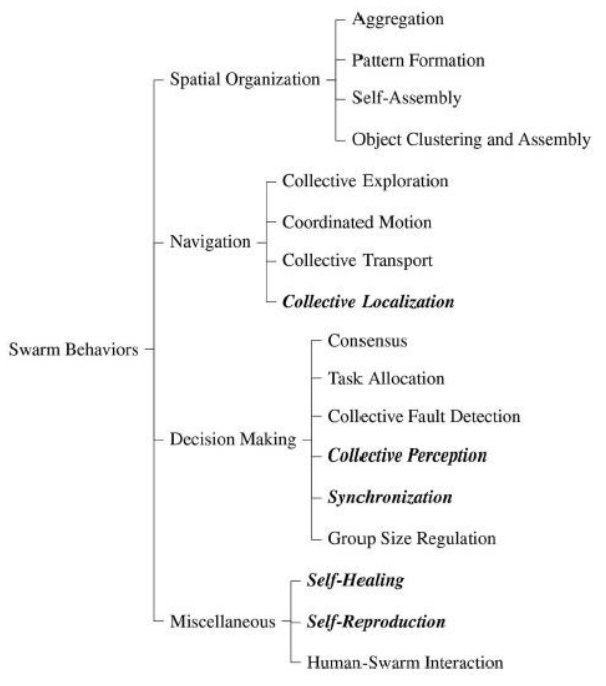
Figure 6. The function of different robotic systems [116].